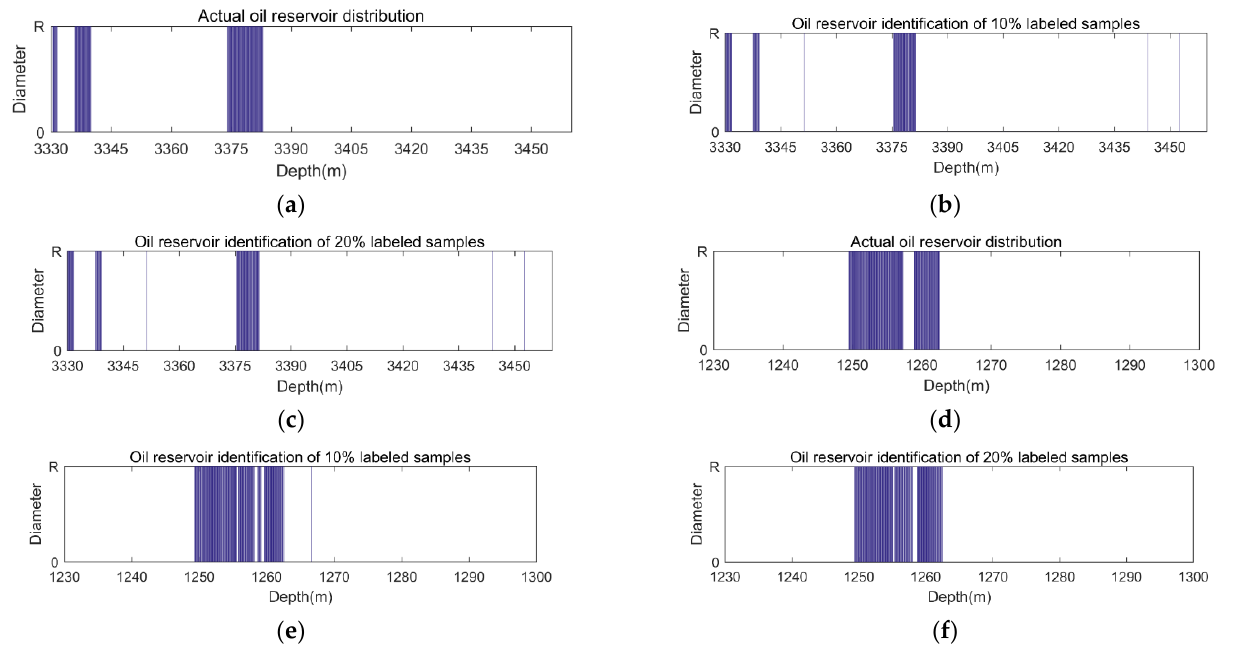
Figure 5. Original and predicted oil layer distribution for two wells, where ( a – c ) is the distribution for well 1, and ( d – f ) is the distribution for well 2.